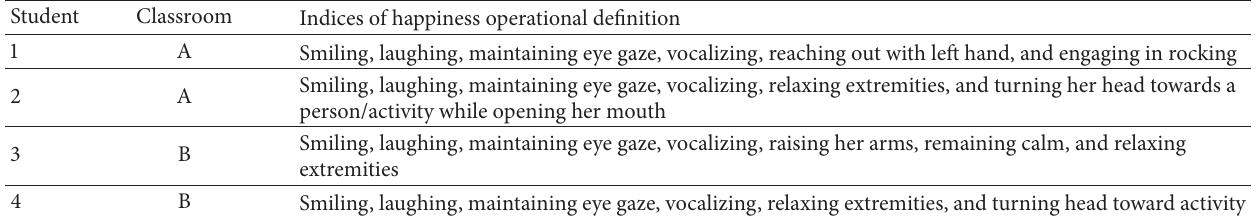
Table 2: Individual student operational definitions for behaviors associated with